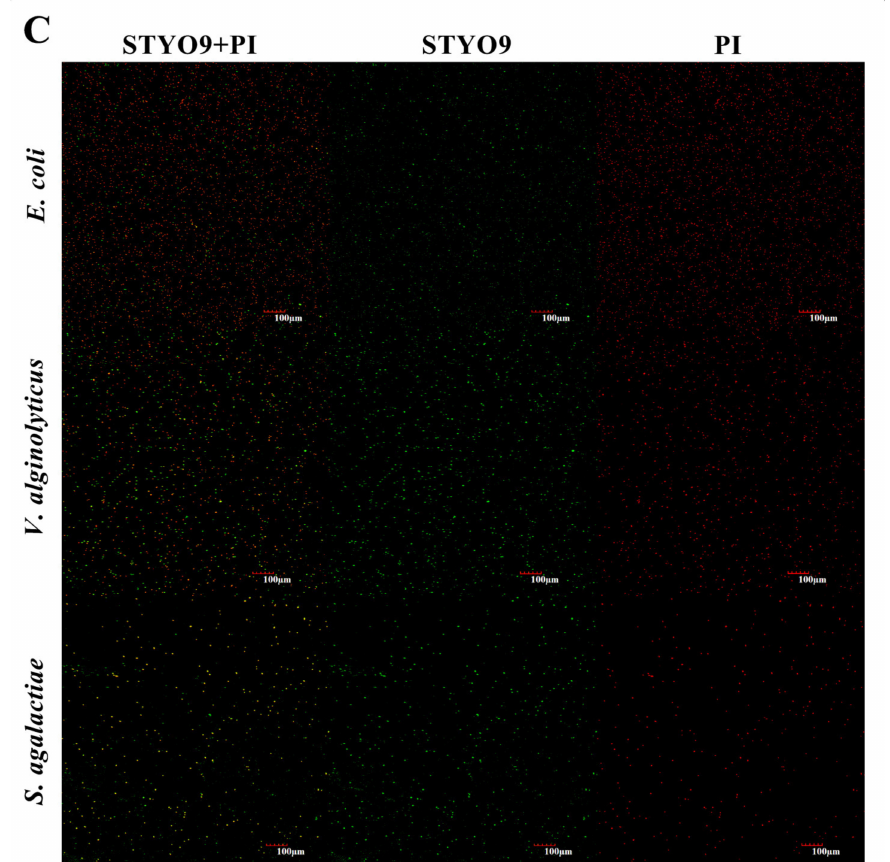
Figure 8. E. coli , V. alginolyticus and S. agalactiae treated with rToBPI1/LBP and rToBPI2/LBP proteins were used to observe the permeability of bacterial cell membrane. PBS was used as a control. ( A ) the bacteria treated with PBS; ( B ) rToBPI1/LBP treated bacteria; ( C ) rToBPI2/LBP treated bacteria; STYO9 is shown in green, and PI is shown in